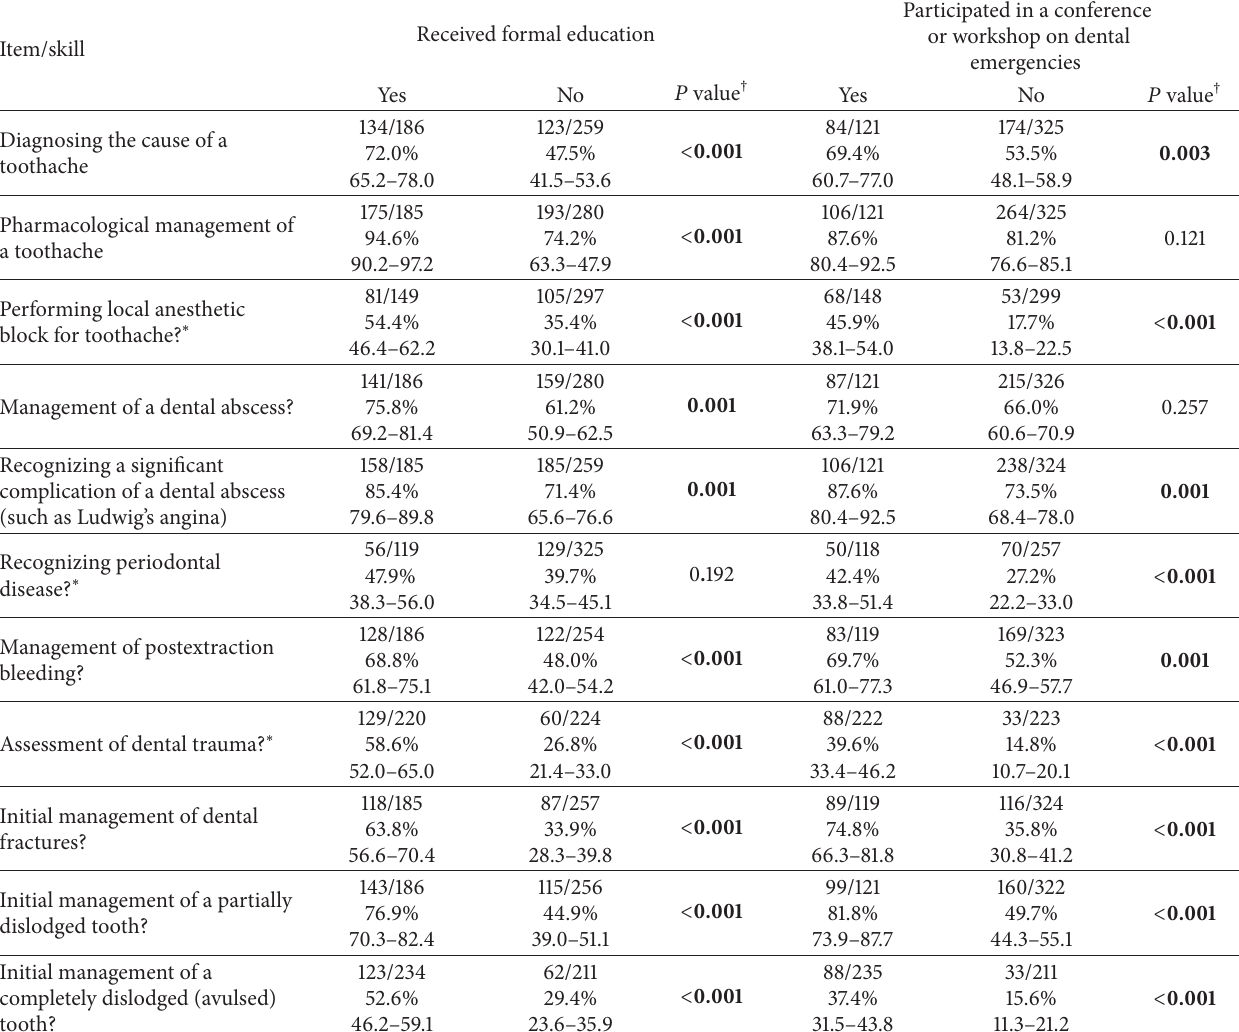
Table 3: Participants who agreed/strongly agreed to being confident in specific skills according to receipt of formal education and participation in workshops and